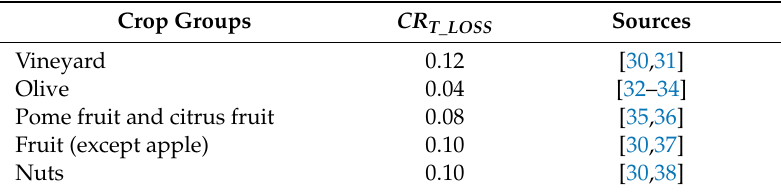
Table 2. CR T_LOSS values assigned by crop